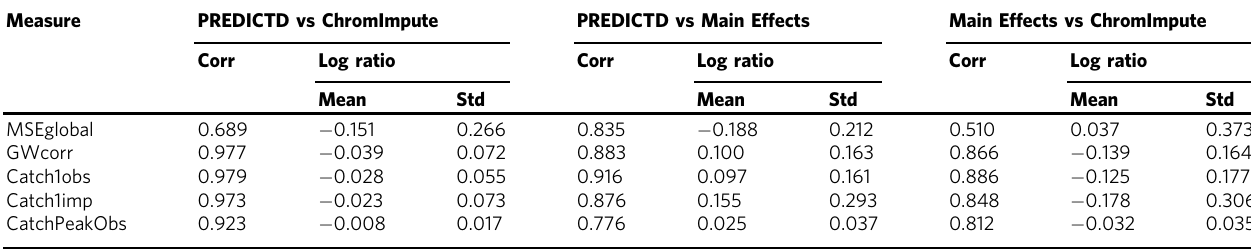
Table 1 Statistics comparing models across fi ve quality measures show PREDICTD outperforms Main Effects and has similar performance to ChromImpute